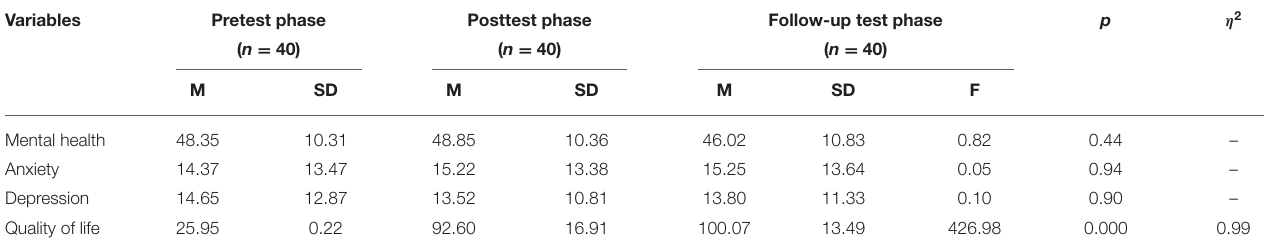
TABLE 2 | Mean difference of anxiety disorder, depression, quality of life, and mental health between pretesting phase (T-0), posttesting phase (T-1), and follow-up phase (T-2) in Pakistan students during COVID-19 epidemic lockdown ( N = 40). Variables Pretest phase Posttest phase Follow-up test phase